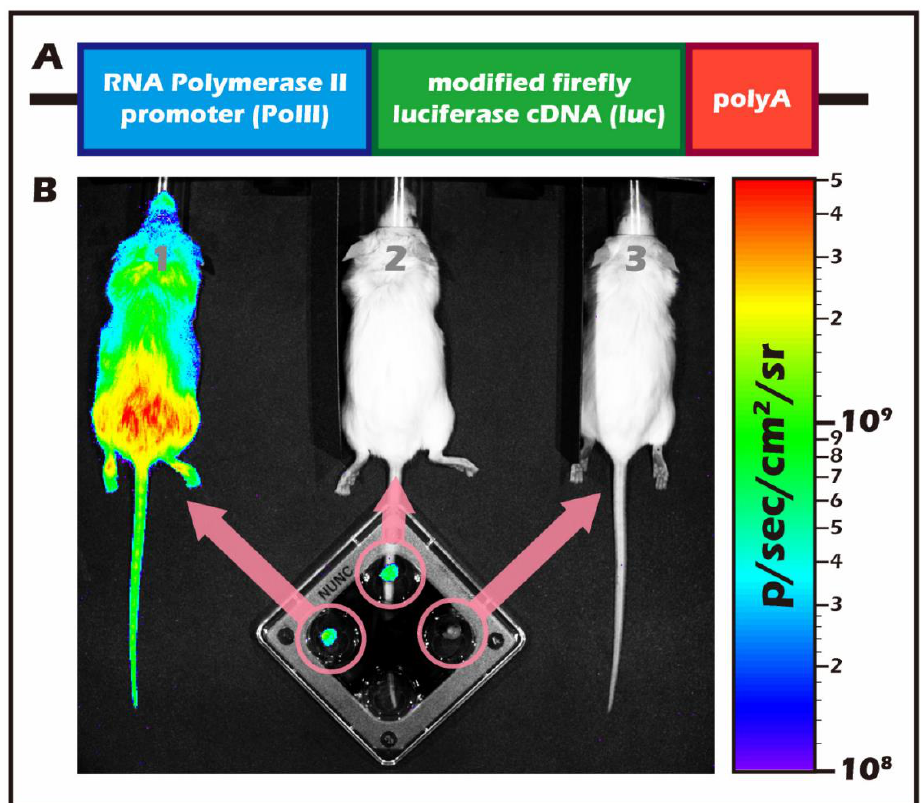
Figure 14. ( A ) Schematic design of the transgenic construct including the 712 bp mouse RNA Polymerase II ( PolII ) promoter and a modified firefly luciferase cDNA (Promega pGL-2). ( B ) FVB/N-Tg ( PolII-luc ) Ltc transgenic donor mice (left-1) were treated with luciferin; the light emitted by the transgene reaction was detected with the IVIS imaging system. The luciferase expression was detectable in all organs of the transgenic mouse including the isolation of intact testis independently (middle-2). No light emission was detected from a wild-type donor intact testis isolated from the recipient mice (right-3).